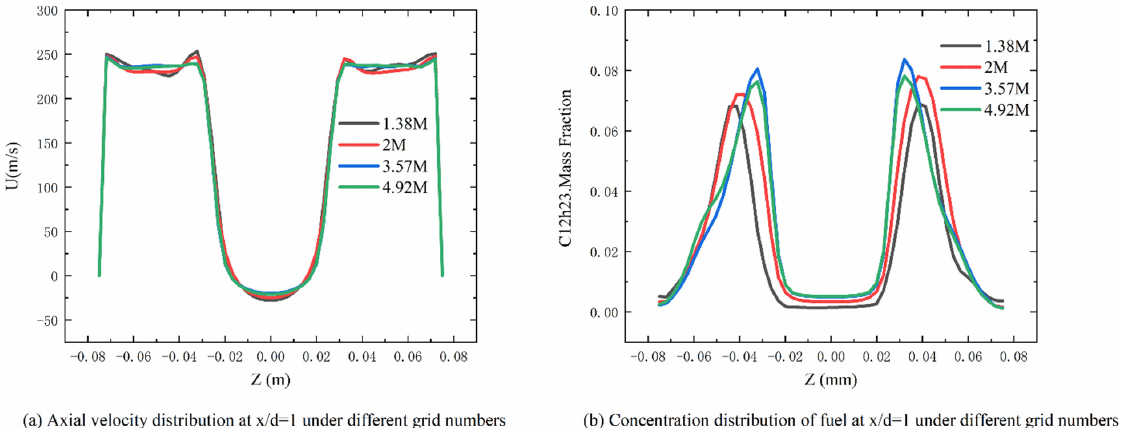
Figure 3. Axial velocity and fuel concentration distribution under different grid numbers.